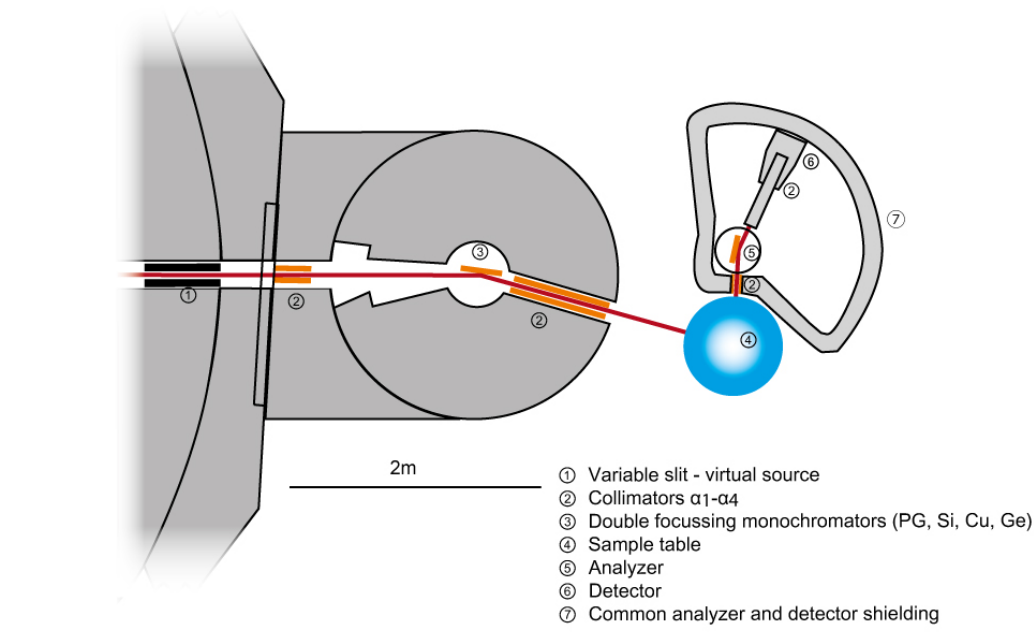
Figure 2: Schematic drawing of